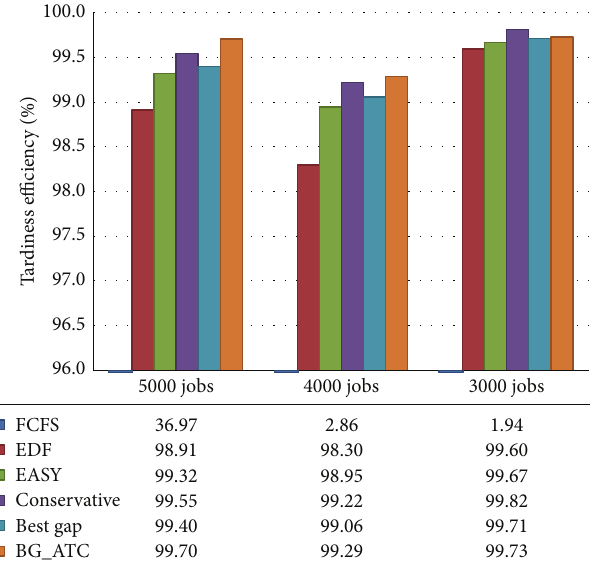
Figure 2: Tardiness efficiency under metacentrum